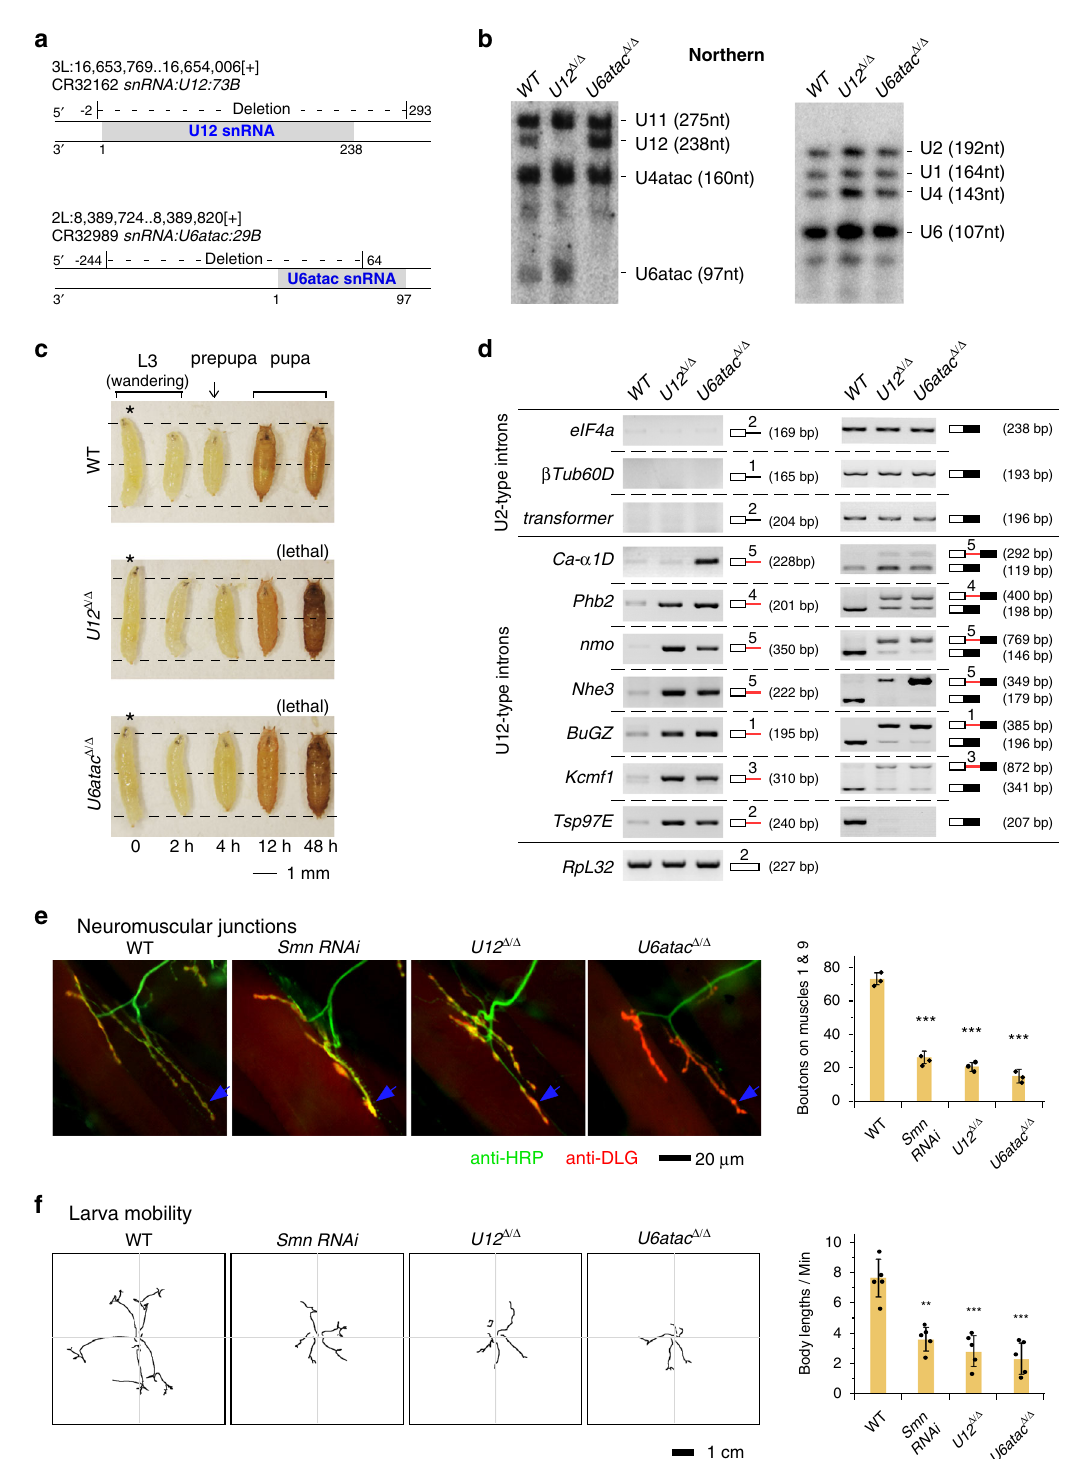
Fig. 1 Precise deletion of U12 and U6atac snRNAs by CRISPR-Cas9 system results in defective splicing of U12-type introns and SMA phenotypes in Drosophila . a Deletion of U12 snRNA and U6atac snRNAs in Drosophila by CRISPR/Cas9 system. Gene loci and deleted regions are indicated. b Validation of deletion strains by northern blotting. Positions and sizes of the U2- and U12-type snRNAs are indicated. c Both the U12 Δ / Δ and U6atac Δ / Δ strains are lethal at the pupal stage. Pictures of deletion and WT strains are shown from L3 wandering to pupal stages. d Splicing of U12-type introns are inhibited in deletion strains. Two sets of ampli fi cation primers of RT-PCR were used for each intron analysis. Ampli fi cation regions are indicated; black lines: U2-type introns; red lines: U12-type introns; boxes: exons. Analyses of other U2- and U12-type introns are shown in Supplementary Fig. 1. e Decreased neuromuscular connection in the U12 Δ / Δ and U6atac Δ / Δ strains. Green: neuron visualized by HRP antibody; red: presynaptic and posterior membranes visualized by DLG antibody. Boutons of NMJ in the colocalized regions are counted under microscopy ( Smn RNAi : p = 0.00016; U12 Δ / Δ : p = 0.00013; U6atac Δ / Δ : p = 9.3e − 5). f Hindered larval locomotion of the U12 Δ / Δ and U6atac Δ / Δ strains ( Smn RNAi : p = 0.00101; U12 Δ / Δ : p = 0.00036; U6atac Δ / Δ : p = 0.00019). Path lengths of larval locomotion are recorded and normalized to body lengths. Data represent the mean ± SD from fi ve representatives of each strain, ** p < 0.01, *** p < 0.001. p values were calculated using two-sided t -test. Source data are provided as a Source Data fi